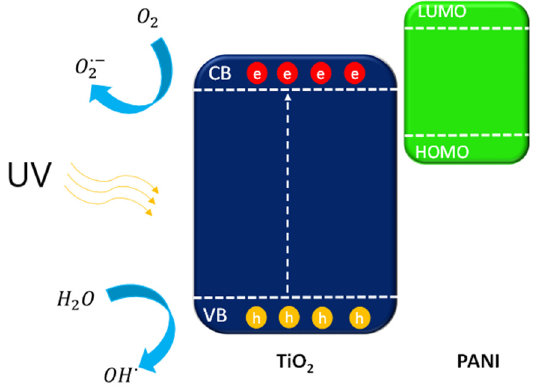
Figure 15. Mechanism of PANI–TIO 2 nanocomposite excitation under UV light.